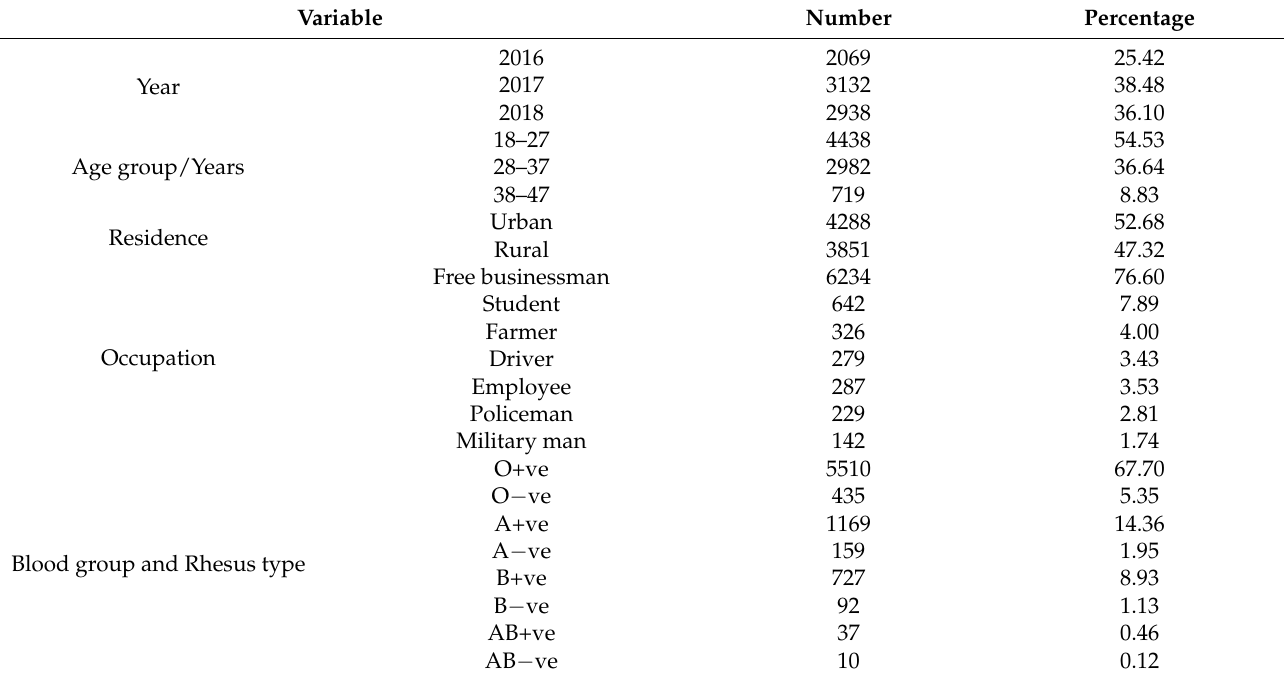
Table 1. Characteristics of blood donors ( n = 8139).